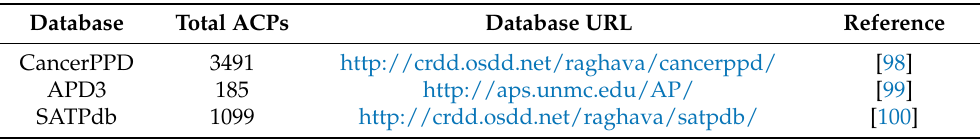
Table 3. List of ACP